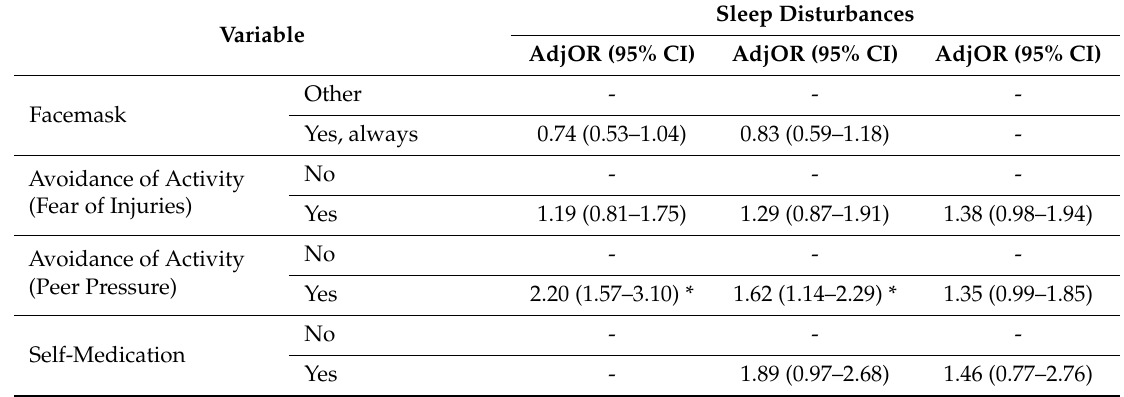
Table 4. Prevalence of depression, anxiety and sleep disturbances. Comparison of the present study with other relevant works.